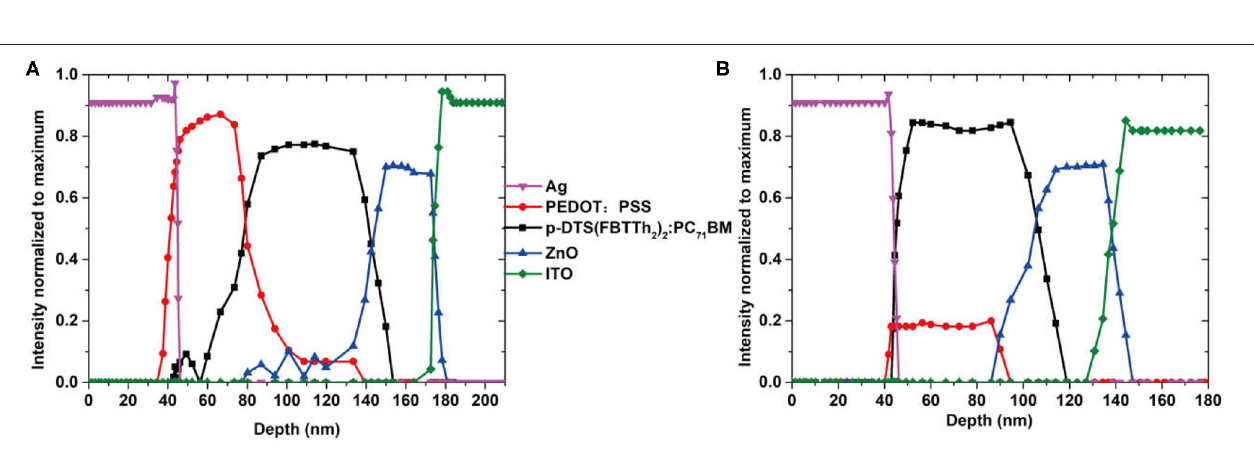
Frontiers in Physics | www.frontiersin.org